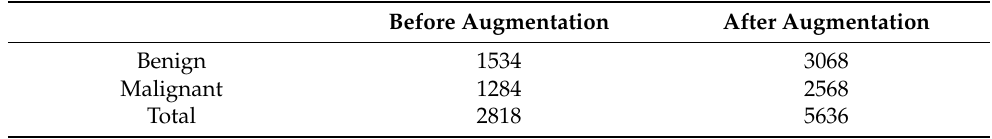
Table 2. Dataset Description of training images.